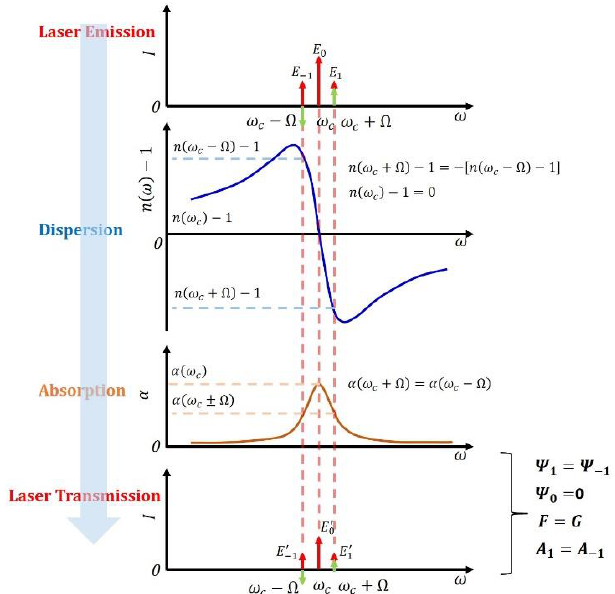
Figure 1. Schematic of the laser transmission through a gas sample due to the simultaneous absorption and dispersion. Red arrows: intensity modulation (IM) sidebands; green arrows: frequency modulation (FM) sidebands.